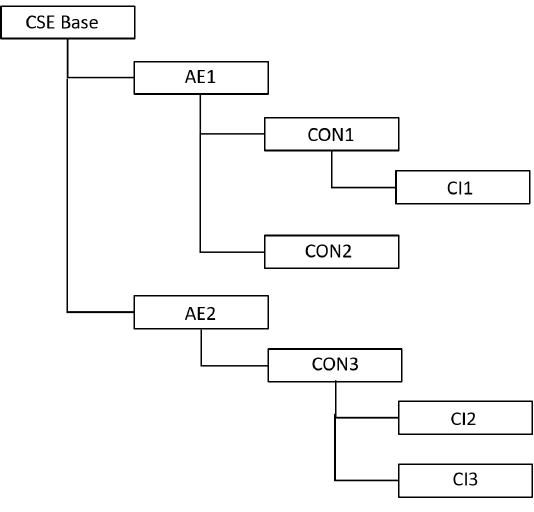
Figure 1. The OneM2M resource